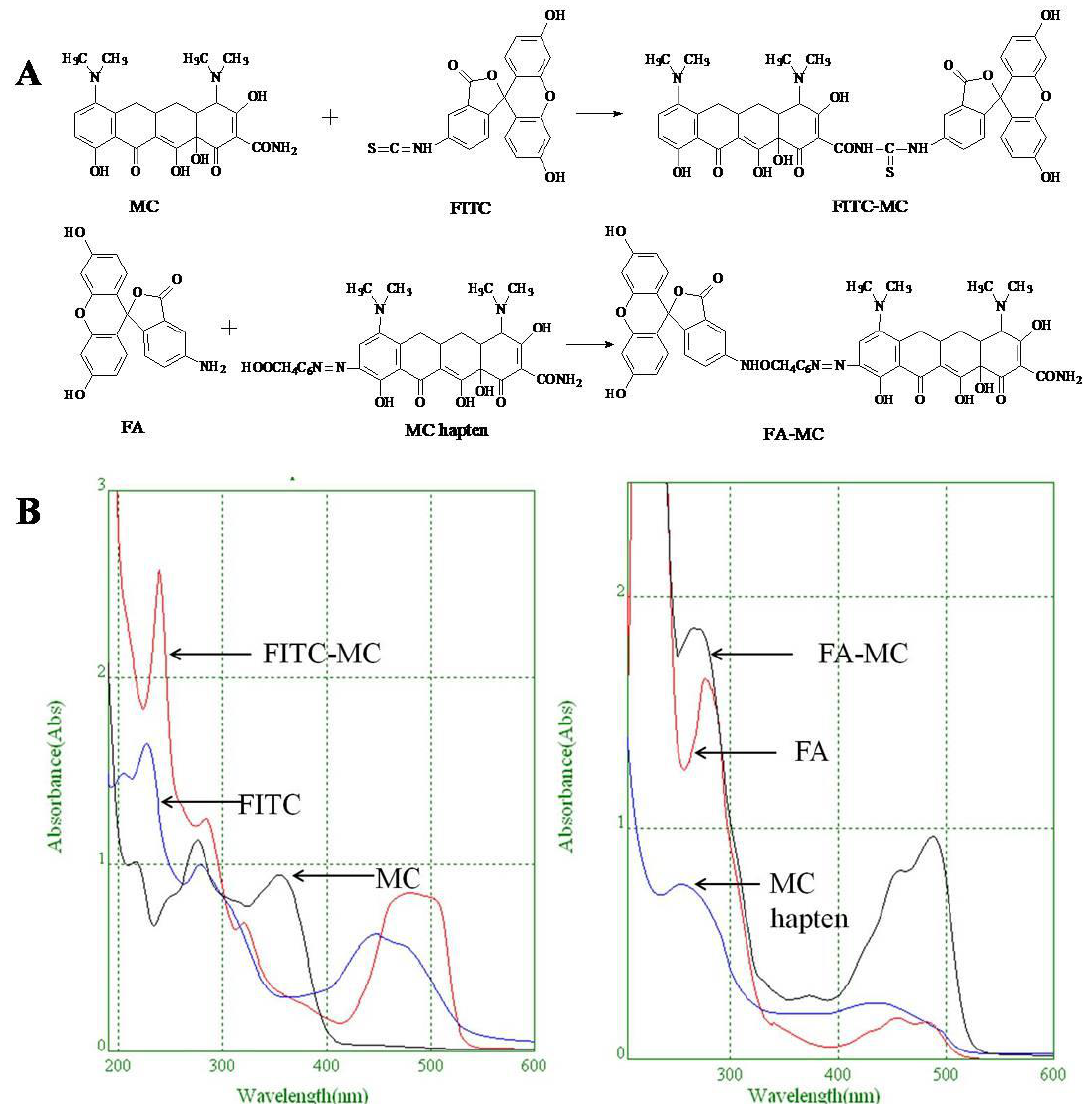
Figure 1. ( A ) Synthetic routs and ( B ) UV scanning diagrams of FITC-MC and FA-MC.